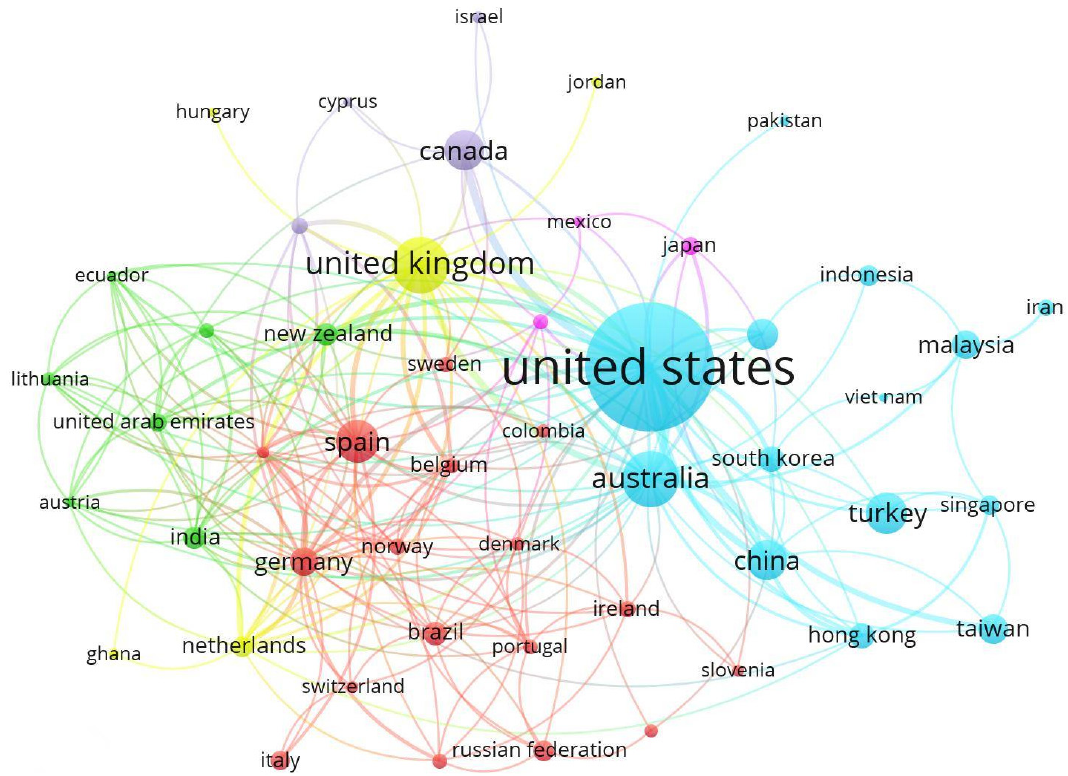
Figure 6. Network of cooperation based on co-authorship between countries (2004–2018).